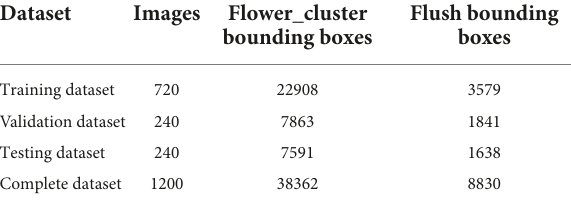
TABLE 1 Numbers of images and pieces of sample information contained in the dataset.